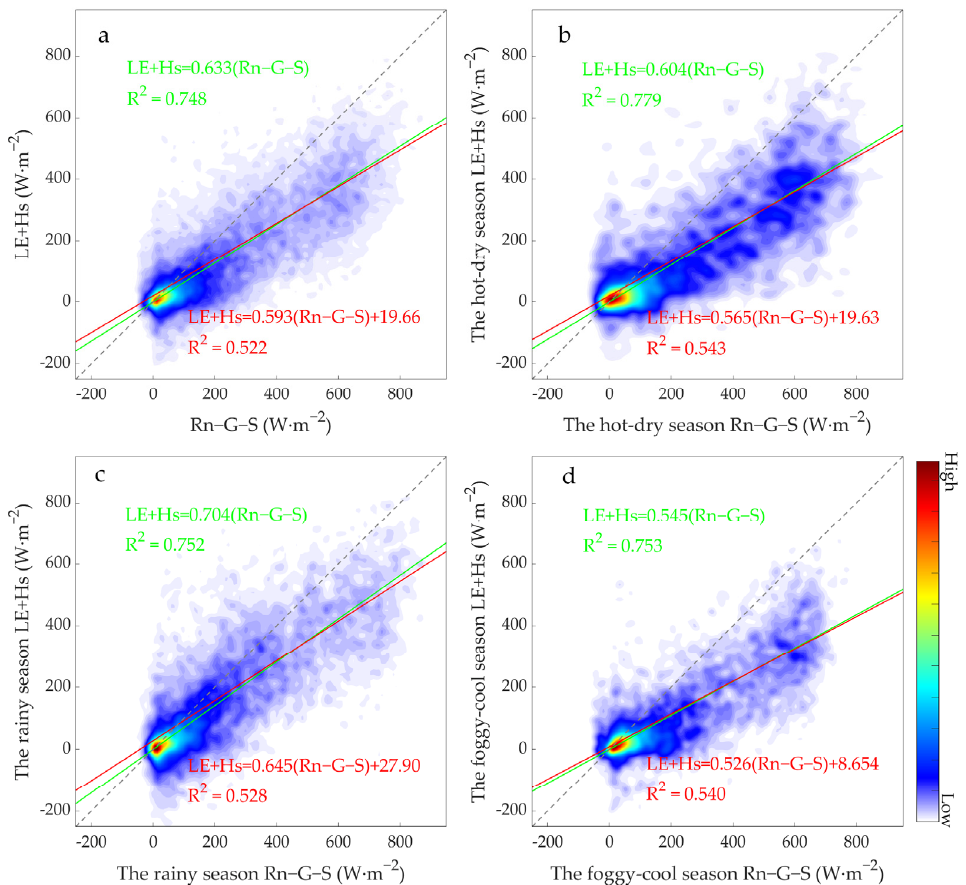
Figure 5. Two-dimensional kernel density distribution and linear regression plots of turbulent flux (LE + Hs) and available energy (Rn − G − S) in different seasons: ( a ) throughout the year, ( b ) the hot-dry season, ( c ) the rainy season, ( d ) the foggy-cool season. The color bar of the kernel density distribution represented the degree of aggregation of data points, with the colors ranging from white to red corresponding to the density of data points from low to high progressively. The diagram shows the gray-dashed line past the origin with a slope of 1. The solid green line is obtained by forcing the intercept to 0, and the solid red line has both slope and